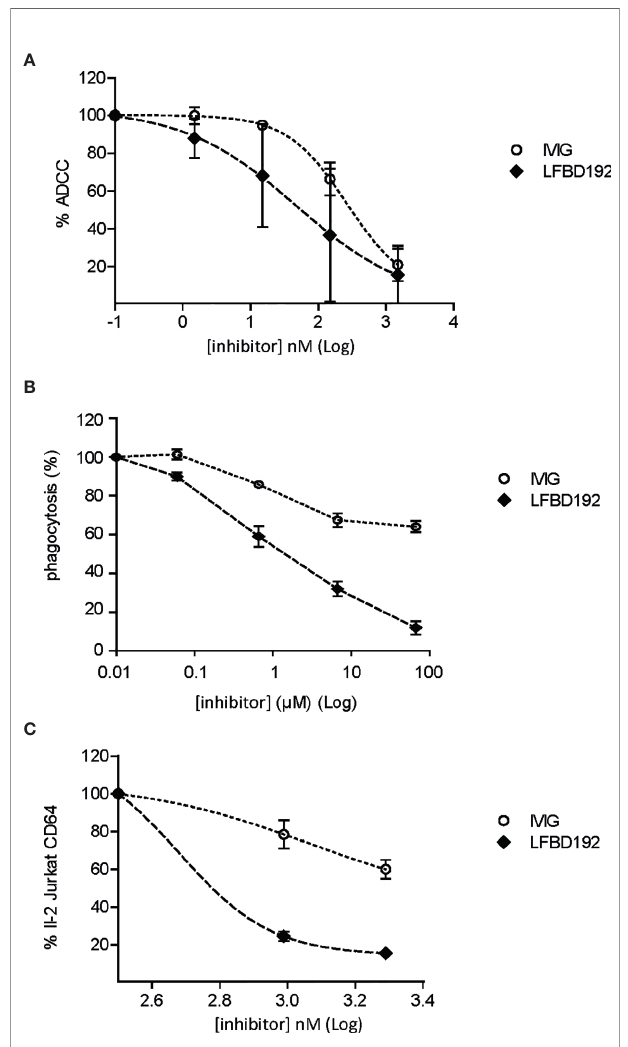
FIGURE 3 | LFBD192 vs IVIg in three models of inhibition of immune complex-mediated cell lysis. (A) Percentage of antibody-dependent cell- mediated cytotoxicity (ADCC) inhibition for anti-D antibody-treated O + human red blood cells (data are the means of two experiments from different human donors, each experiment performed in triplicates). (B) Percentage of phagocytosis inhibition of human anti-platelet IgG1 (anti-CD41)-treated fl uorescence-labeled platelets obtained from human donors mediated by Fc g RIIIa-transfected THP1 cells with 6.66×10 – 5 , 6.66×10 – 6 , 6.66×10 – 7 , and 6.66×10 – 8 M of 10% IVIg or LFBD192 (data represent the means ± SEM of three experiments from three different human donors, each experiment performed in duplicates). (C) Percentage of inhibition of Fc g RI-mediated IL-2 secretion by Fc g RI-expressing Jurkat T cell lymphomas (CD20-negative) in co-culture with CD20-expressing Raji cells rituximab/Raji cells complex (data represent the means ± SEM of two experiments from different human donors, each experiment performed in